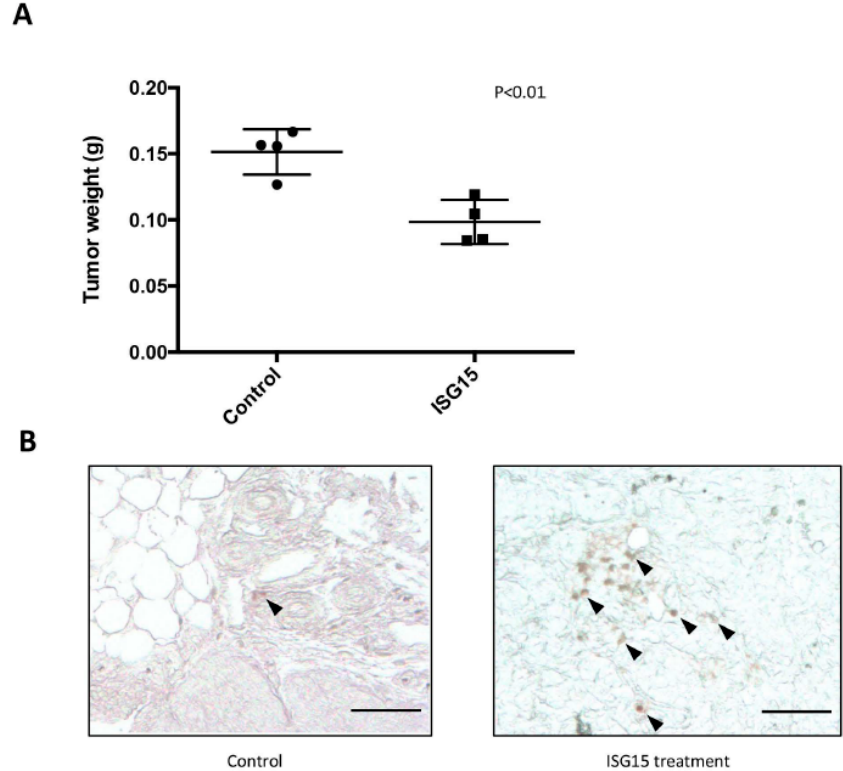
Figure 7. Recombinant ISG15 protein suppressed tumor progression in tumor-bearing animals. ( A ) Administration of 1 mg/kg recombinant ISG15 twice weekly suppress tumor progression in ID8 tumor-bearing C57BL/6 mice. A significant decrease in tumor weight in ISG15 treated mice was observed when compared to PBS treated mice. ( B ) Immunolocalization of CD8+ cells in tissue samples harvested from the ISG15 treated and the control mice demonstrated a significant increase in intraepithelial CD8+ lymphocyte density in ISG15 treated mice than in control mice. (Bar = 100 μ m).